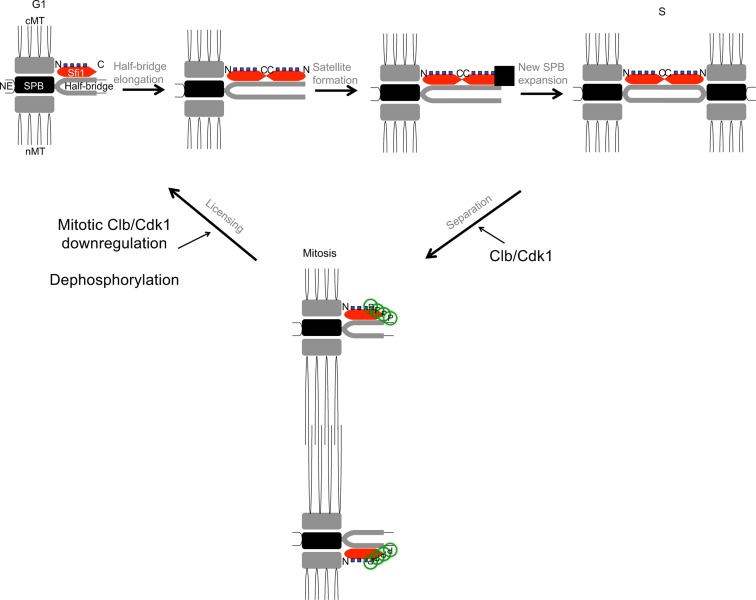
Model for licensing of yeast centrosome duplication via phosphoregulation of Sfi1.Cdk1 activity is required for SPB separation, in which Cdk1 phosphorylates the Sfi1 C terminus, ensuring SPB duplication does not begin until completion of mitosis and downregulation of mitotic cyclin/Cdk1. Dephosphorylation of Sfi1, likely by Cdc14, licenses SPB duplication to allow the next cycle of SPB duplication to begin at G1. cMT: cytoplasmic microtubules. nMT: nuclear microtubules. NE: nuclear envelope. ▪: satellite.